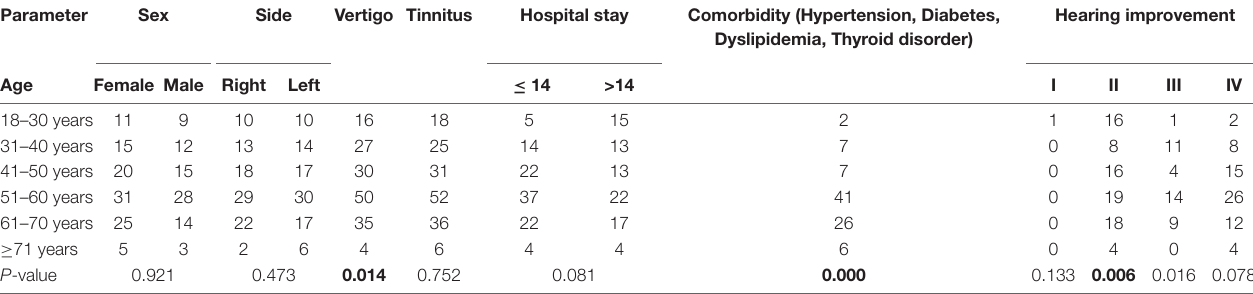
The bold values mean statistic differences.